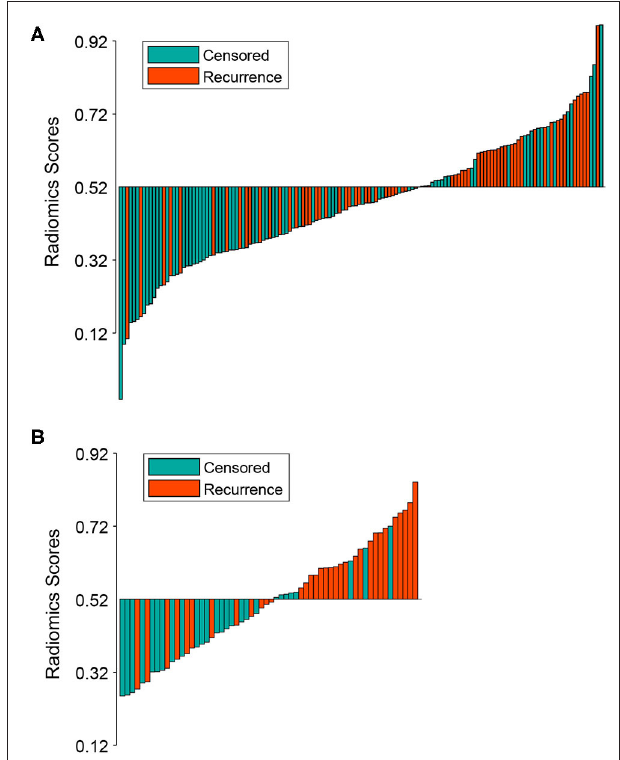
FIGURE 2 | Bar plot of the radiomics signature value for each patient in the training cohort (A) and the validation cohort (B) . Patients with radiomics signature values > 0.52 were allocated into the high-risk group, while patients with values ≤ 0.52 were allocated into the low-risk group. Recurrent and censored patients were marked with a different